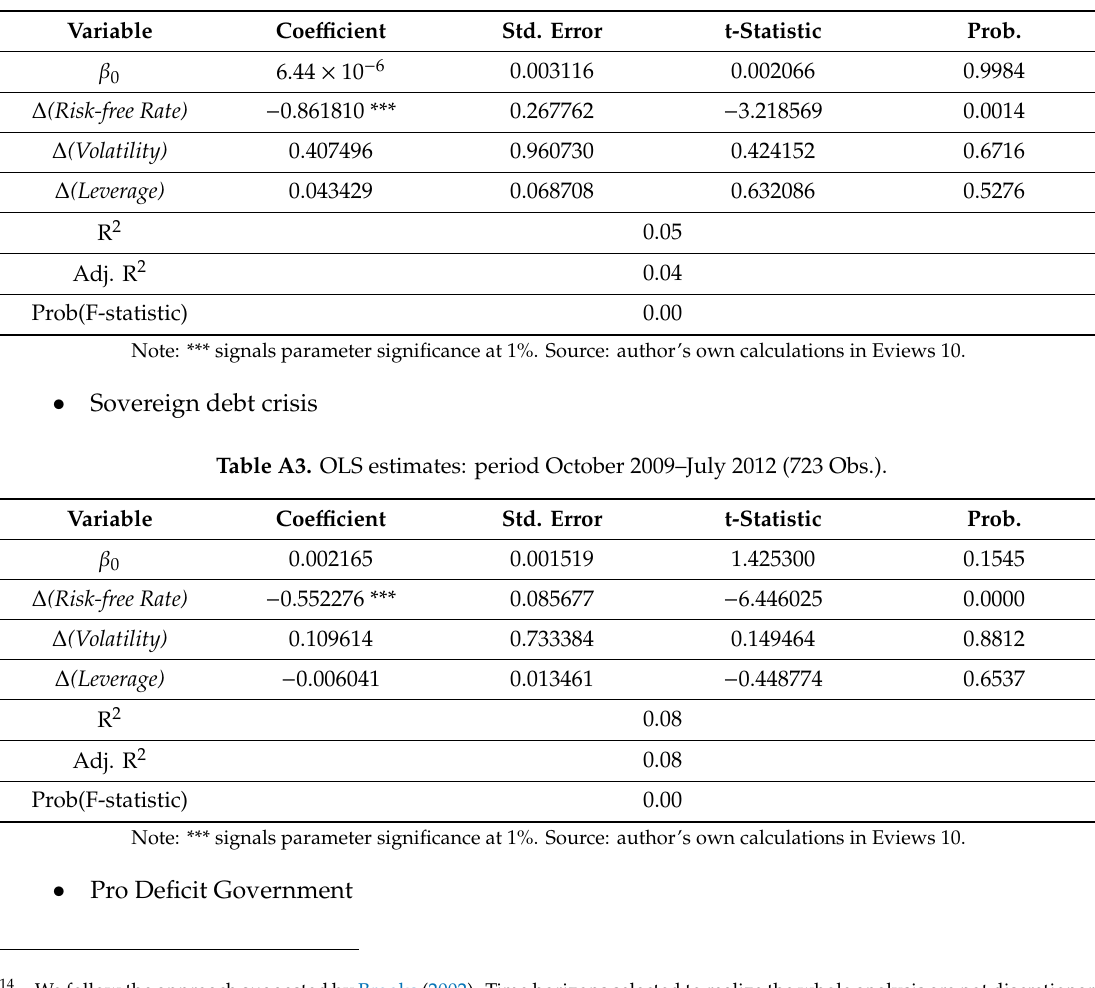
Table A2. OLS estimates: period August 2007–October 2009 (492 Obs.).